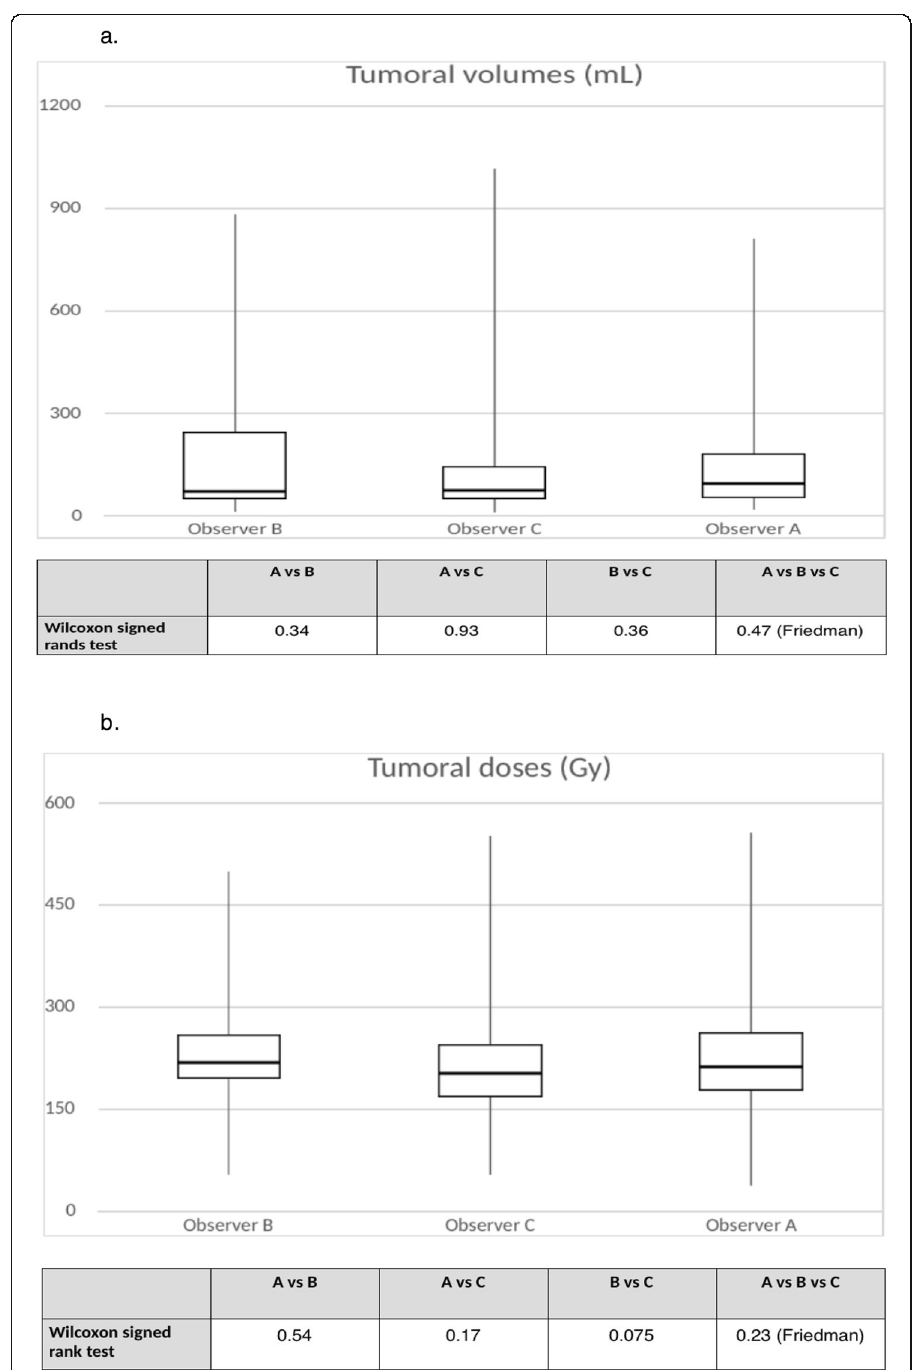
Fig. 3 a Box plots for tumoral volumes and p values from Wilcoxon signed-rank and Friedman tests. The volume in milliliters is plotted on the y -axis, and the observer is plotted on the x -axis. Upper horizontal line of box represents the 75th percentile; lower horizontal line of the box, 25th percentile; horizontal bar within box, median; upper extremity of line outside the box, maximum value; and lower extremity of line outside the box, minimum value. b Box plots for tumoral doses and p values from Wilcoxon signed-rank and Friedman tests. The dose in grays is plotted on the y -axis, and the observer is plotted on the x -axis. Upper horizontal line of box represents the 75th percentile; lower horizontal line of the box, 25th percentile; horizontal bar within box, median; upper extremity of line outside the box, maximum value; and lower extremity of line outside the box, minimum